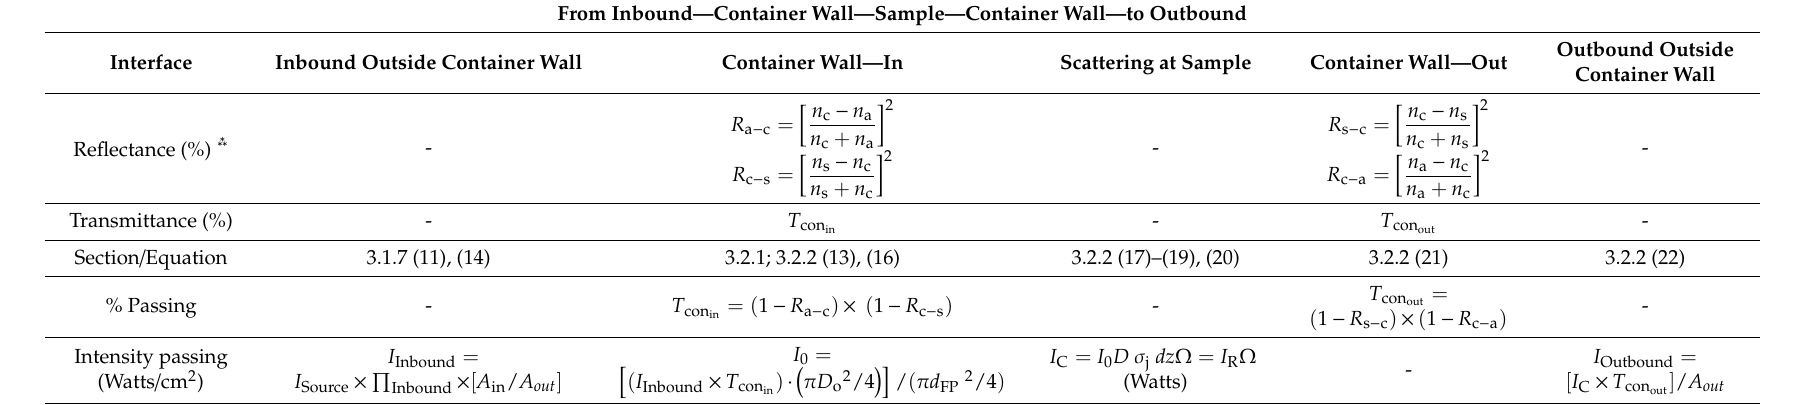
Table 4. Summary of light intensity transfer function at the sample.